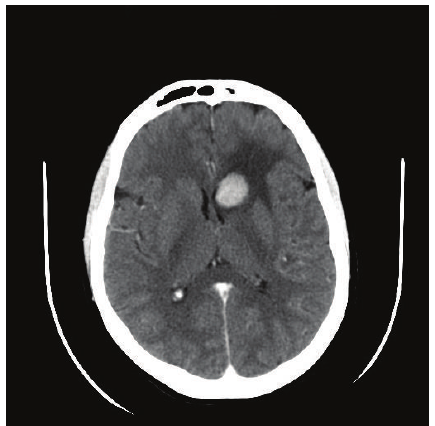
Figure 4: Enhanced axial CT scan of the brain shows multiple enhancing brain lesions seen supratentorially and infratentorially; the largest is seen in left caudate head with surrounding reactive parenchymal